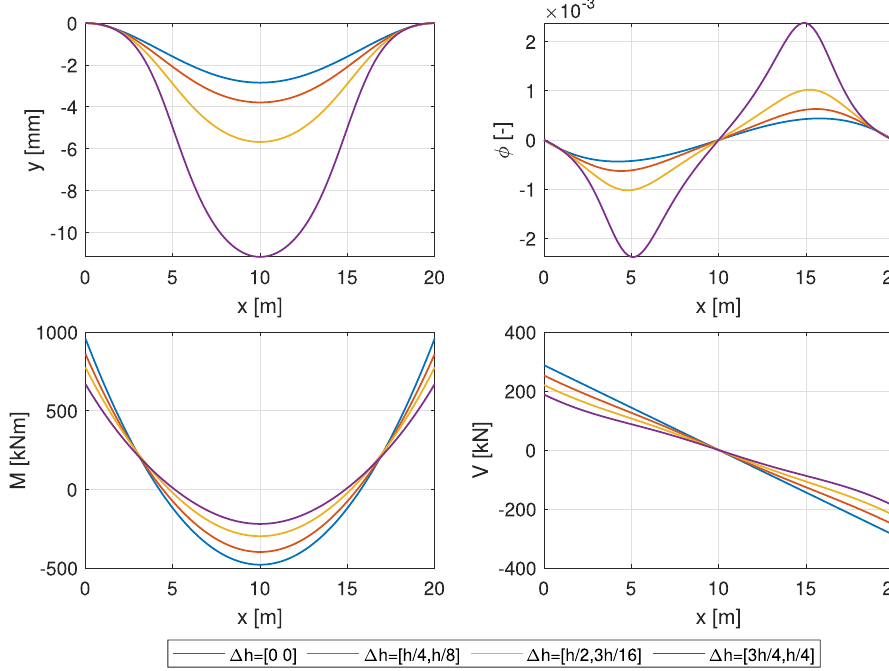
Fig. 6 Comparison among the internal actions and compli- ance parameters (deflection and rotation) with the different imposed maximum emptying values defined in Fig. 5 on a three lobes dog-bone